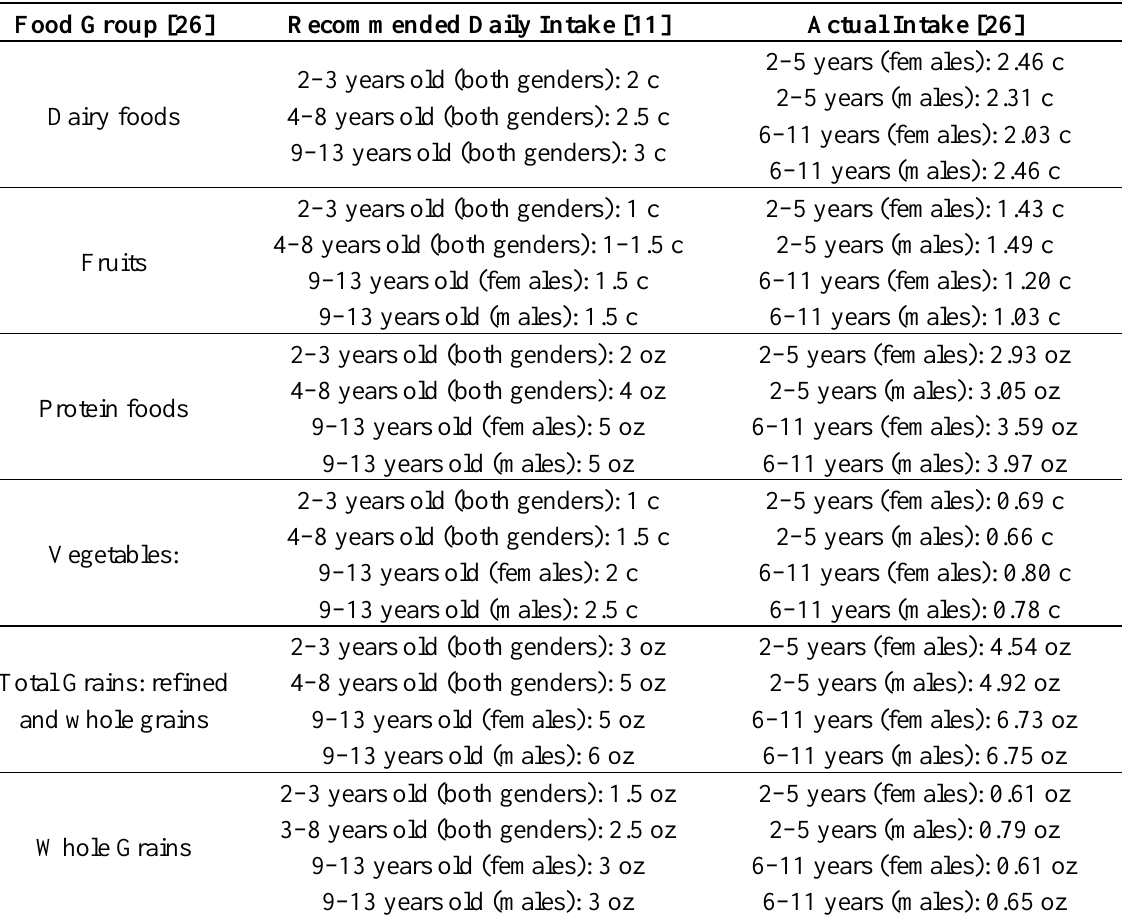
Table 1. NHANES Food Groups: Recommended Intake versus Actual Consumption, Comparisons using Recommendation Information from Choosemyplate.gov and Consumption Data from 2009–2010 NHANES data for Children 2–11 Years Old.